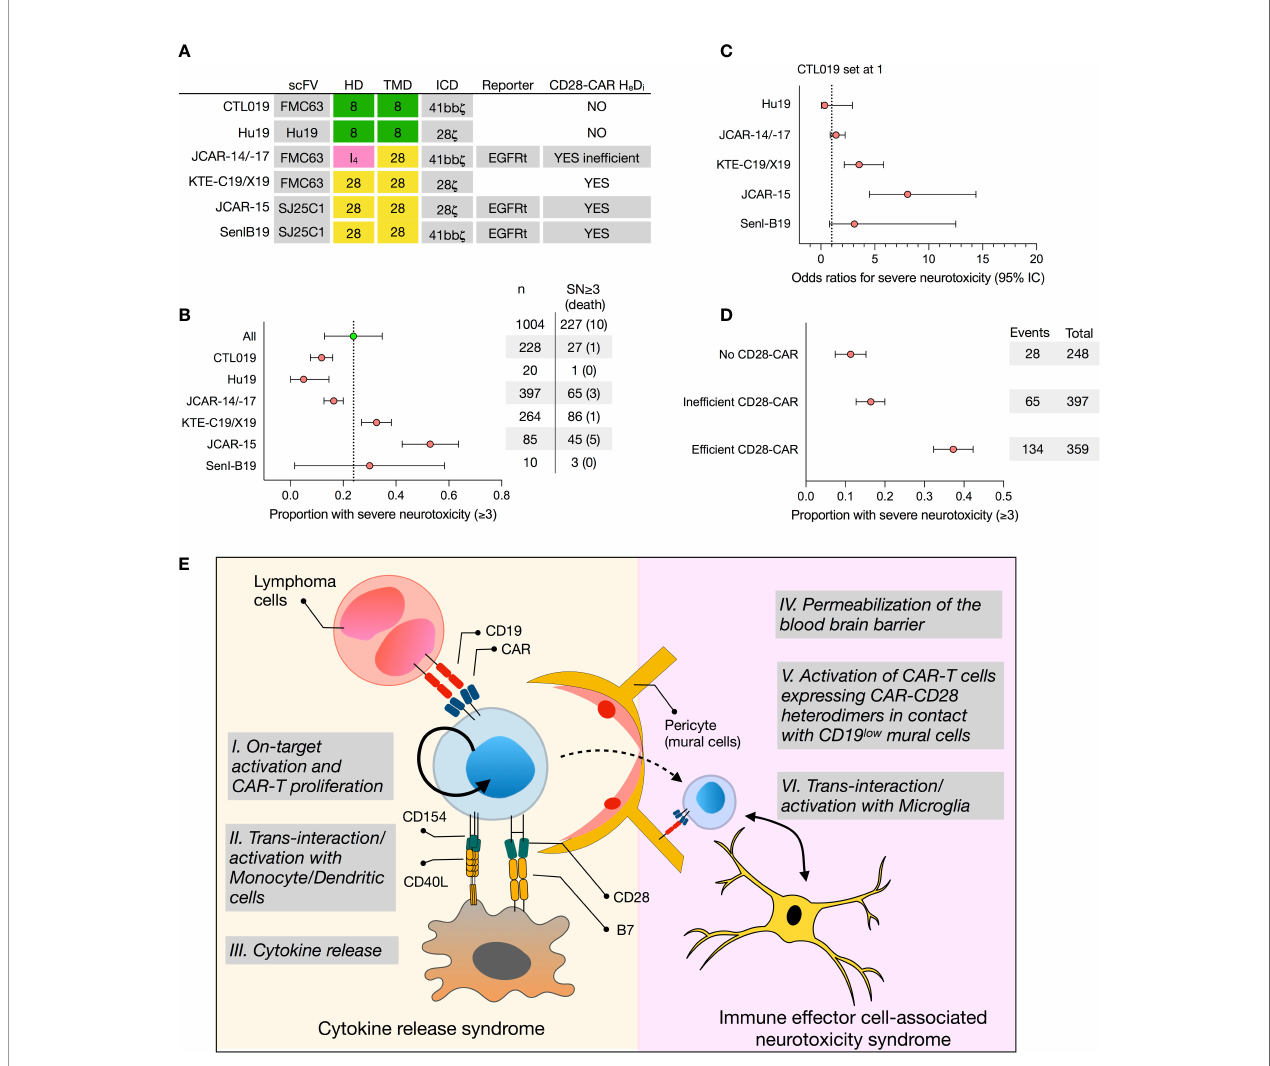
FIGURE 1 | Retrospective analysis of the proportion of severe neurotoxicity of selected CD19 CAR T-cell products and proposed model for CAR T cell-mediated neurotoxicity. (A) Construct designs of 5 selected CD19 CAR T-cell products, namely tisagenlecleucel (CTL019), Hu19, JCAR-14/-17, axicabtagene ciluleucel (KTE-C19), JCAR-15, and SenI-B19, differing by their hinge (HD) and transmembrane (TMD) domain. (B) Forest plot representing untransformed proportions of severe neurotoxicities (SN, grade 3 or higher) among patients treated with CAR T-cell products. Con fi dence intervals (95%) were calculated using binary random effect and DerSimonian-Laird methods with OpenMeta (http://www.cebm.brown.edu/openmeta/index.html). (C) The odds ratios of grade 3 or higher severe neurotoxicity comparing Hu19, JCAR14- /17, KTE-C19, JCAR15, and Senl B19 CAR-T products with CTL019 (set as reference) are shown. Calculations were made on SPSS Statistics (IBM, New York, NY) and based on a Pearson Chi-Square test and logistic regression tests assuming that clinical monitoring among the different studies and CD19 CAR-T-cell product is comparable. (D) Forest plot representing untransformed proportions of severe neurotoxicities comparing CARs with no CD28-CAR heterodimers (Hu19, CTL019), inef fi ciently formed CD28-CAR heterodimers (JCAR-14/17), and ef fi ciently formed CD28-CAR heterodimers (SenIB19, JCAR-15, KTE C19). (E) CAR T cells, following on- target activation (I.), undergo several rounds of proliferation in the absence of antigen. This proliferation, fueled by CD40L-CD40 and B7-CD28 interactions with monocytes and/or dendritic cells (II.), ultimately results in cytokine release syndrome (CRS) (III.). In turn, CRS compromises the blood-brain barrier (IV.), allowing CAR T cells to penetrate the central nervous system (CNS). If CAR-CD28 heterodimers assemble on the cell surface, CAR T cells in the CNS interact with mural cells expressing low levels of CD19 (V.), as well as with microglia expressing co-stimulatory receptors (VI.), triggering immune effector cell-associated neurotoxicity syndrome (ICANS). H e D i , heterodimerization; SN, severe neurotoxicity; HD, hinge domain; TMD, transmembrane domain; ICD, intracellular